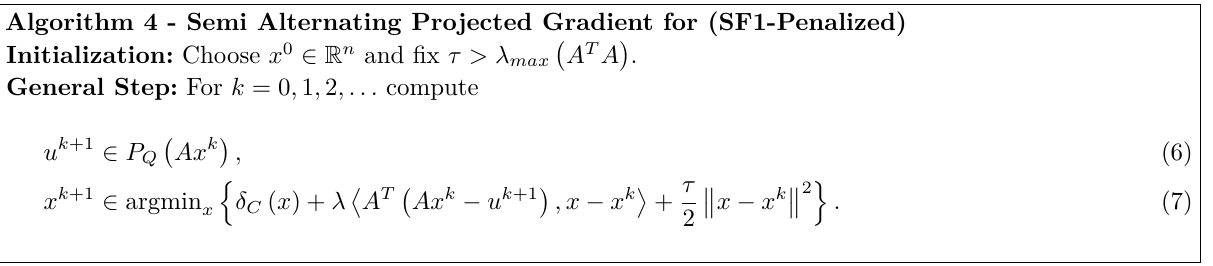
Algorithm 4 - Semi Alternating Projected Gradient for